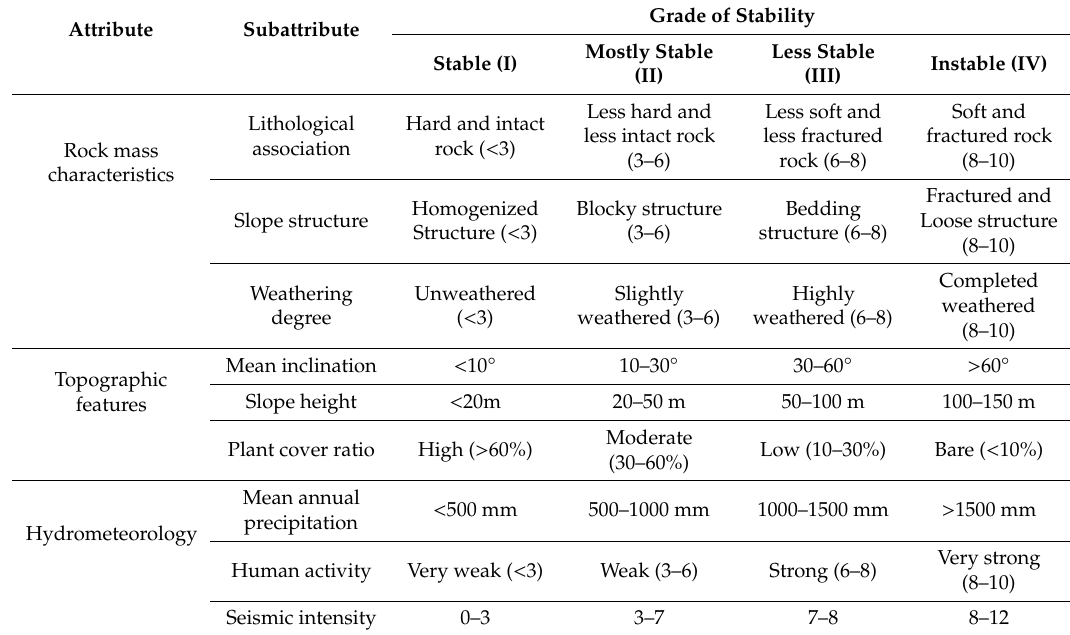
Table 1. Classification of attributes of slopes.